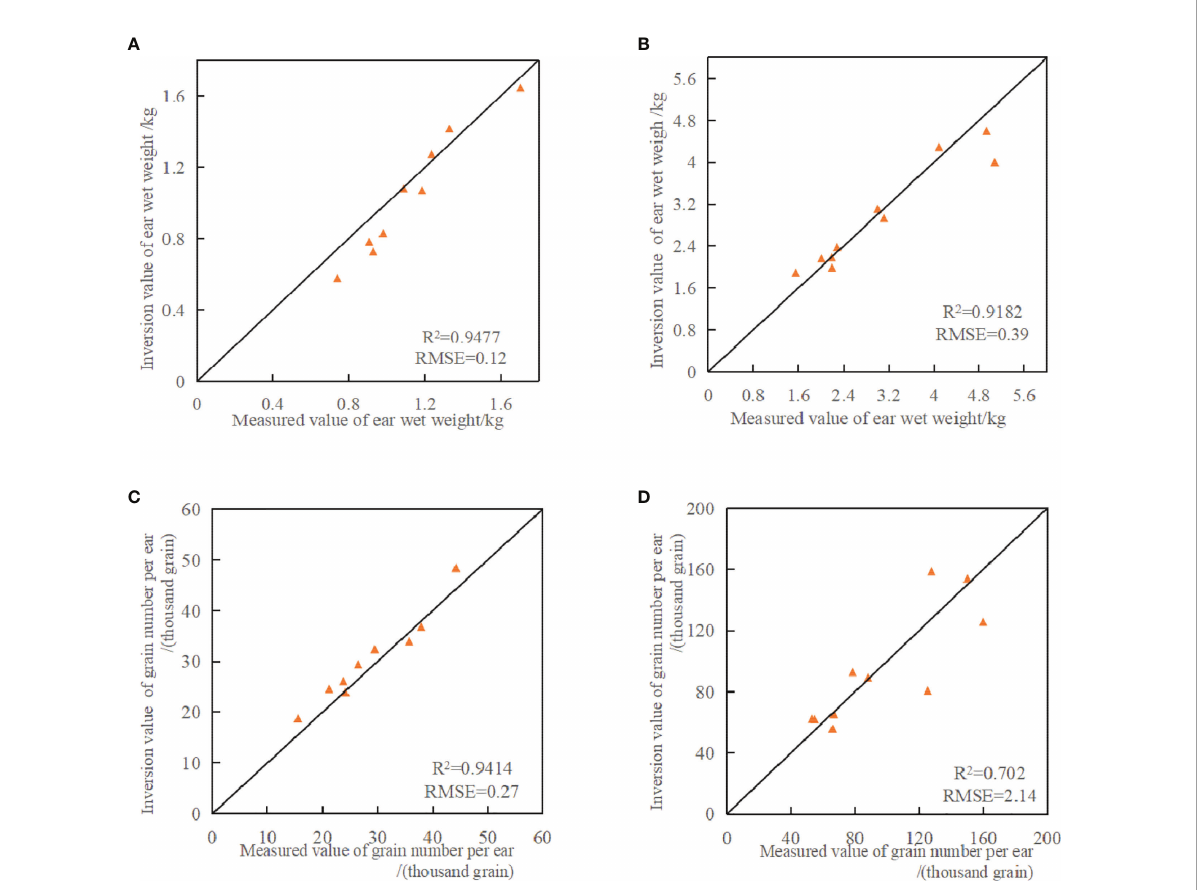
FIGURE 7 Veri fi cation diagram of inversion model of wet weight of ear and grain number per ear. (A) Model veri fi cation of measured values and inversion values of wet weight of rice ear M wetB ; (B) Model veri fi cation of measured values and inversion values of wet weight of rice ear M wetCDE ; (C) Model veri fi cation of measured values and inversion values of grain number per ear N B ; (D) Model veri fi cation of measured values and inversion values of grain number per rice ear N CDE .